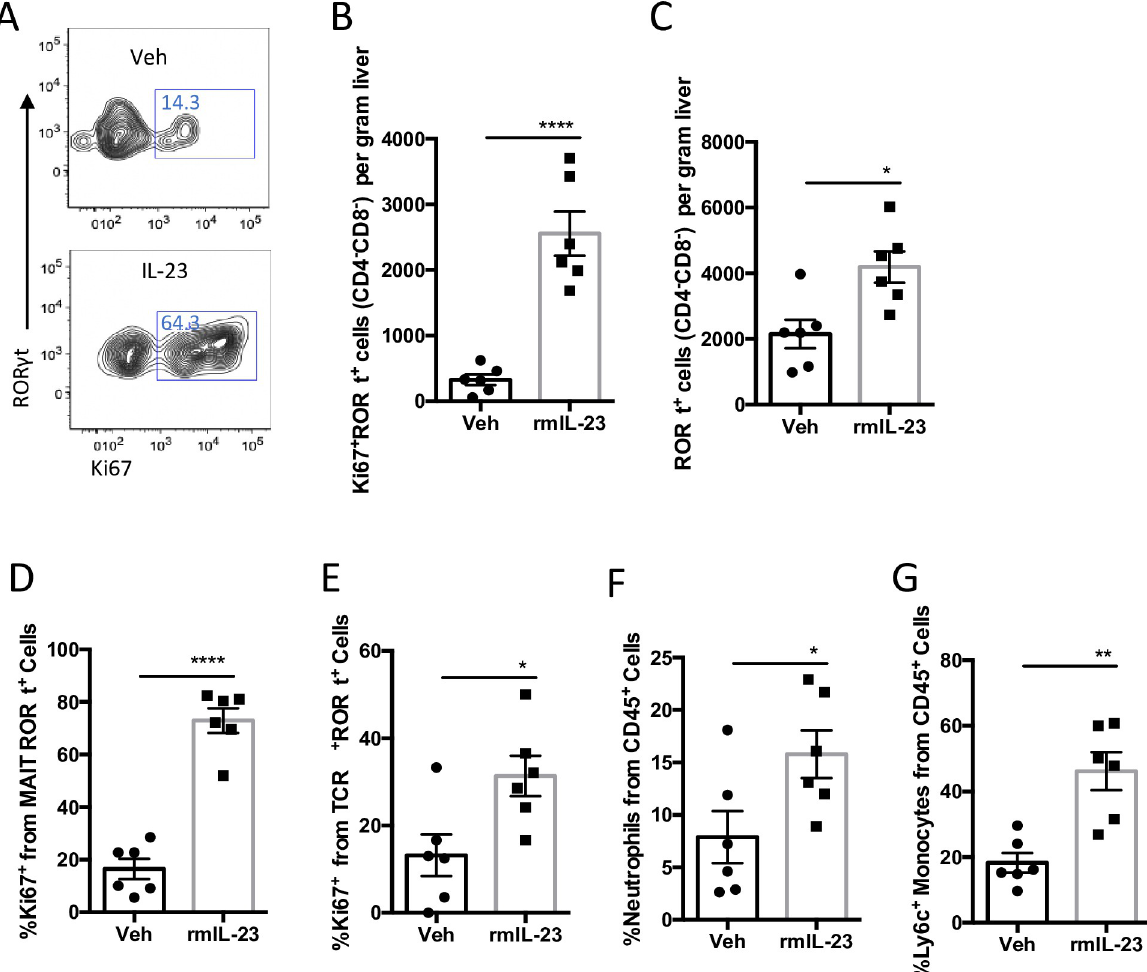
Fig 1. rmIL-23 administration induces ROR γ t proliferation in liver. FACS staining was performed in liver NPCs isolated from mice administered either PBS or recombinant mouse IL-23 (rmIL-23) by IP injections (A-G): Representative FACS gate, IL-23 induced greater frequency of ROR γ t + Ki67 + T Cells gated from CD3e + CD4 - CD8 - (A). Total ROR γ t + Ki67 + T Cells, indication of proliferative cell, and total ROR γ t (CD4-CD3-) T Cells quantified in the liver (B-C). Percentage quantification of Ki67+ of ROR γ t + MAITs and ROR γ t + γδ T Cells (D-E). Percentage of Neutrophils and Ly6c + monocytes from CD45+ Cells (F-G). Groups: Vehicle (PBS): n = 6, rmIL-23 (3x 0.5ug): n = 6. Data represents mean ± S. D. � p < 0.05, �� p < 0.001, ���� p < 0.0001, two-tailed